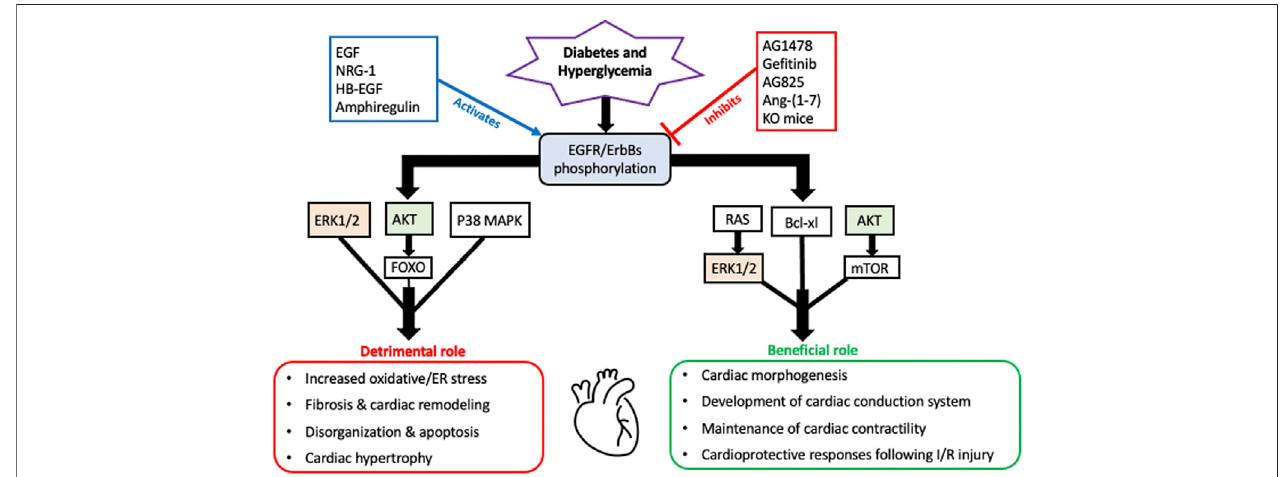
FIGURE1| Aschematichighlightingtheoverallbene fi cialanddetrimentalactionsofEGFR/ErbB receptorsandtheirdownstream signalingeffectorsinthediabetic heart. It appearsthat all four EGFR/ErbB receptors are necessary for the development ofthe heart during embryogenesis and bene fi cial for the proper functioning of the adult heart including a key role in maintenance of cardiac contractility. EGFR/ErbB2 signaling is also essential for normal cardiomyocyte function. Acute stimulation of EGFR/ErbB receptor signaling is also essential for activation of salvage pathways and cardiac recovery following I/R injury. In addition to these bene fi cial actions, EGFR/ErbB receptor signaling can also have detrimental outcomes. Persistent or chronic upregulation of EGFR/ErbB receptor signaling has been involved in the development of cardiac dysfunction and pathologies including fi brosis, remodelling and hypertrophy. Several key downstream effectors are involved in mediating both actions with some notable overlaps such as AKT and ERK1/2 (highlighted)- implying that they too can have dual actions depending on the pathophysiological context akin to the role of their upstream EGFR/ErbB receptors (see main text for further details and references).